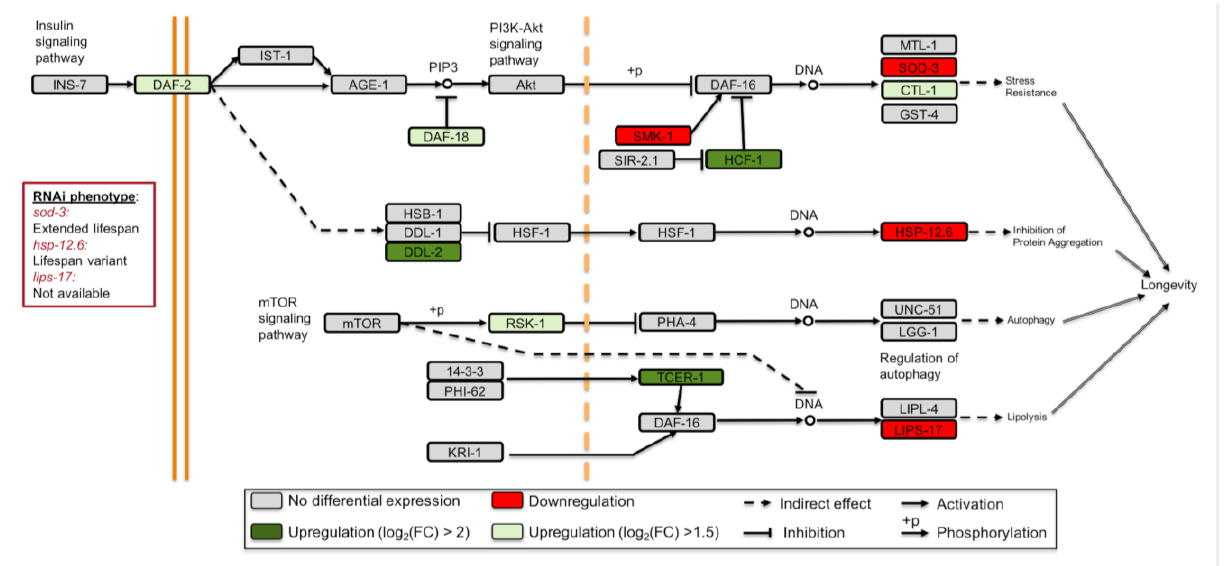
Figure 3. Longevity regulating pathway genes are differentially expressed under simulated micro- gravity. Adopted from the KEGG longevity regulating pathway — worm (cel04212).